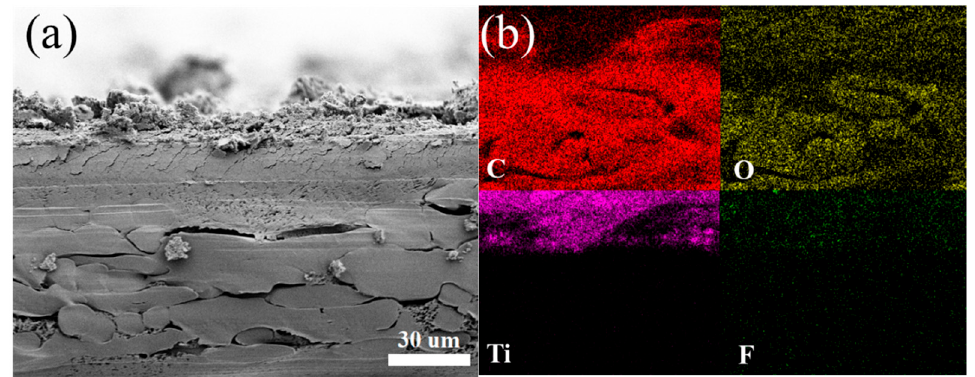
Figure 3. ( a ) Cross-sectional FESEM images of Ti 3 C 2 T x /PPy coated electrospun PVDF ( b ) EDS elemental mapping images of C, O, Ti, and F for the Ti 3 C 2 T x /PPy coated electrospun PVDF.